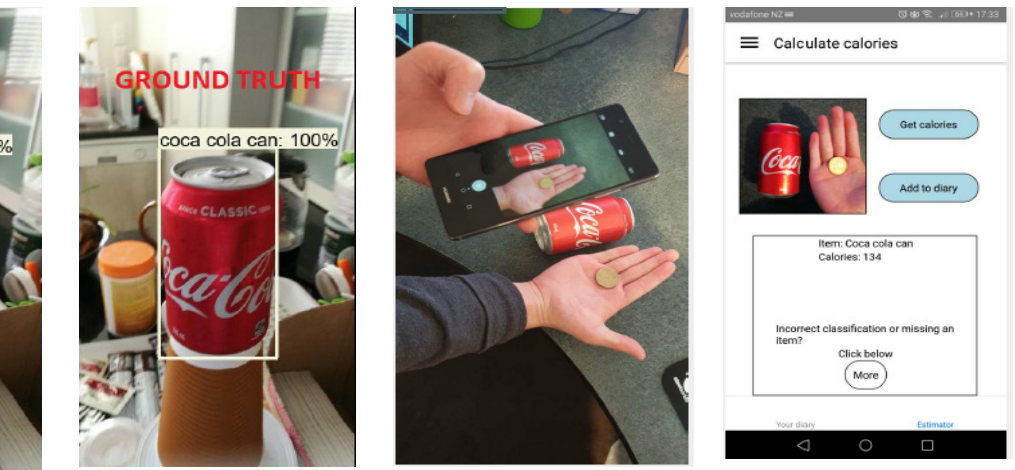
Figure 8. Volume estimation of a Coca-Cola can.